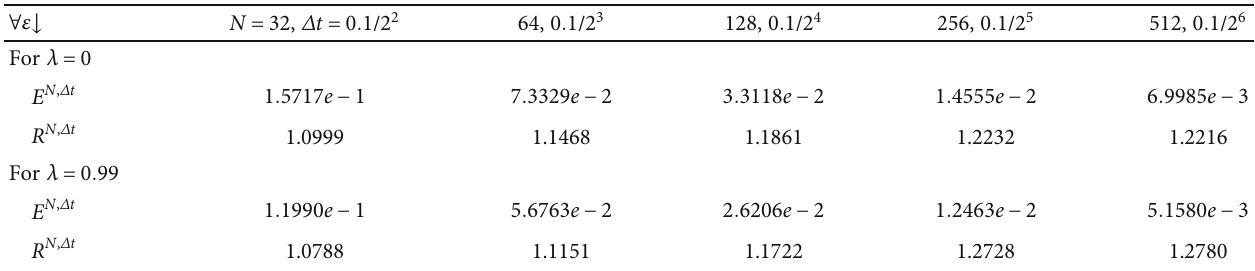
Table 4: Comparison of ε -uniform values for λ = 0 and λ = 0 : 99 using the proposed